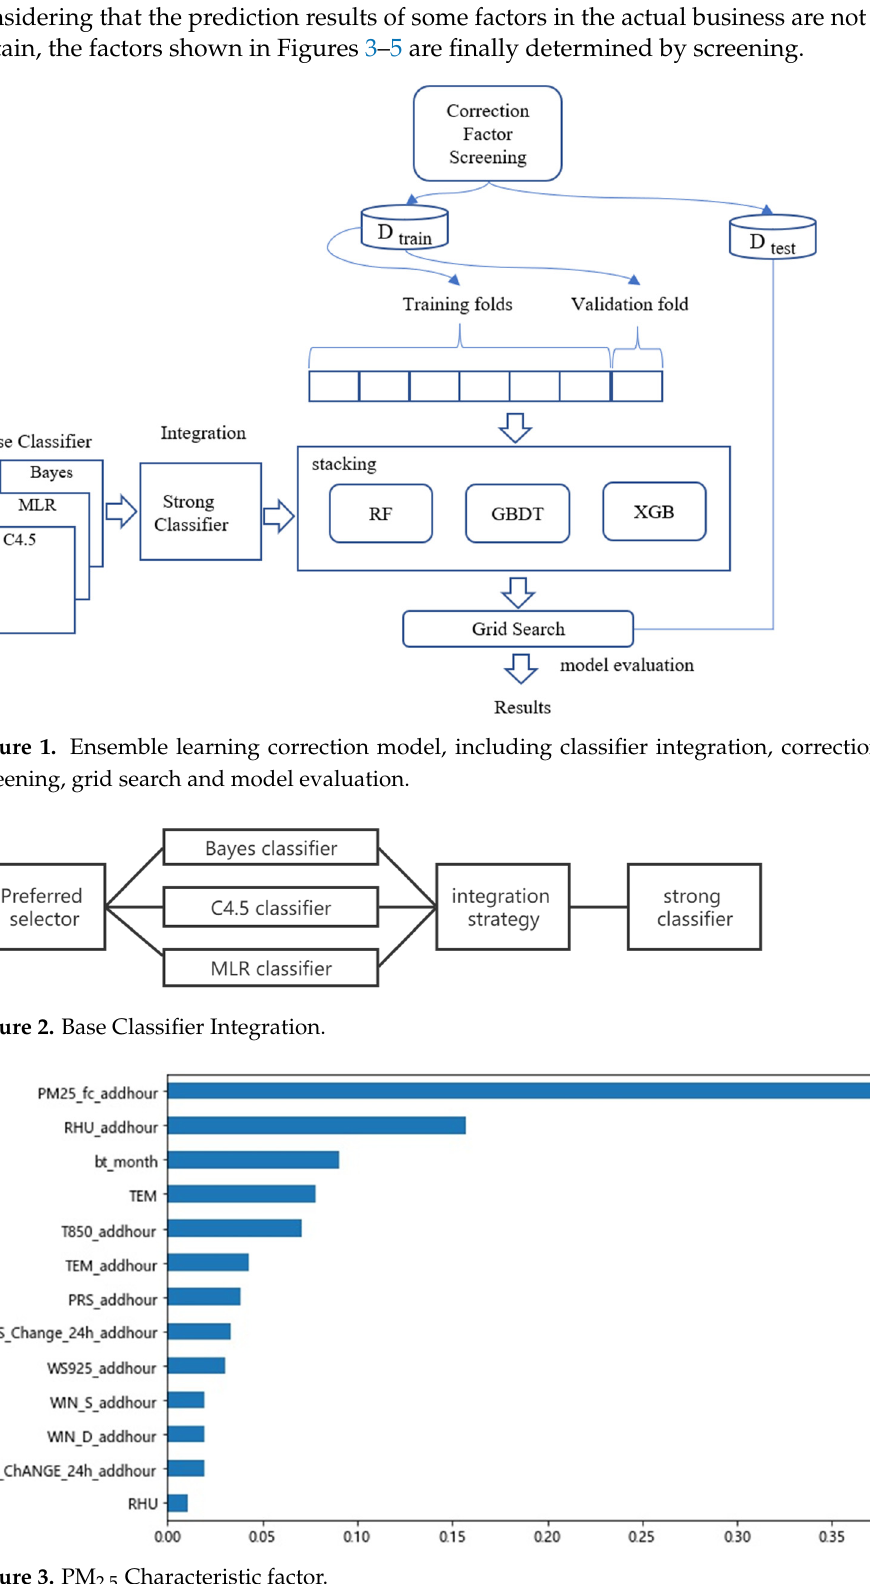
Figure 4. PM 10 Characteristic factor.